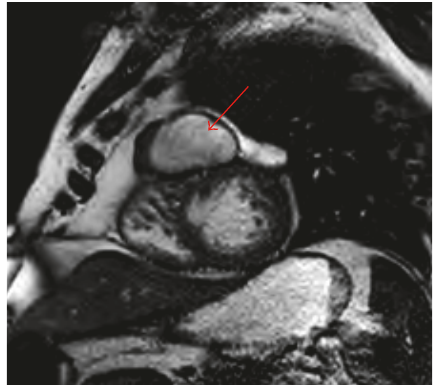
Figure 3: CT pulmonary angiogram. 6.4 × 4.3 cm peripherally calcified hyperattenuating lesion along the intraventricular groove highly concerning for a giant left anterior descending coronary artery aneurysm (red arrow).